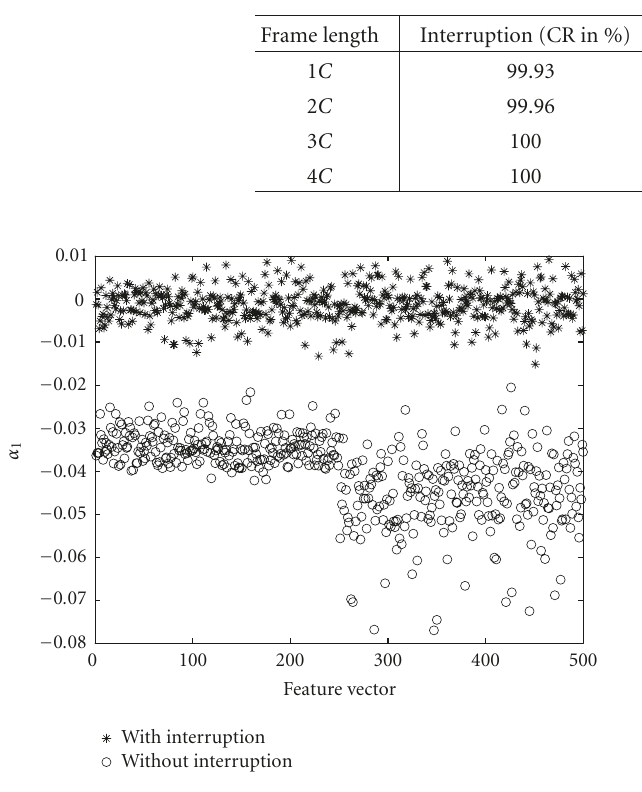
Figure 18: HOS-based features extracted from f for interruption α